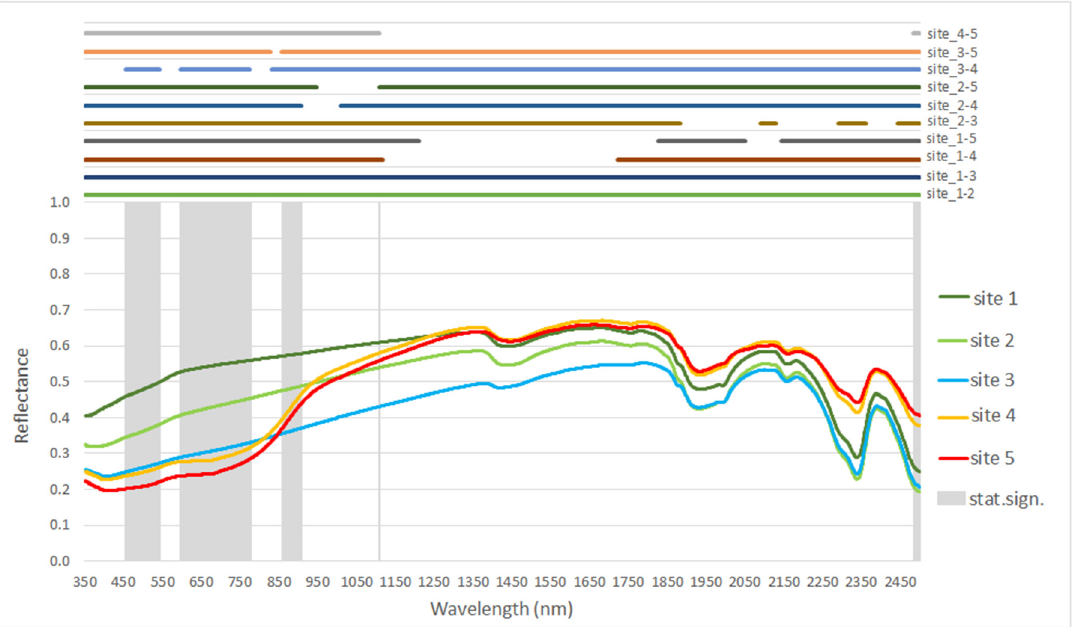
Figure 5. Statistically signi fi cant di ff erences between re fl ectance spectra of the test sites (signi fi cance level α = 0.05). The di ff erences between particular pairs of curves are shown by overlapping level α = 0.05). The differences between particular pairs of curves are shown by overlapping horizontal horizontal lines, and di ff erences between all sites are shown by gray columns. lines, and differences between all sites are shown by gray